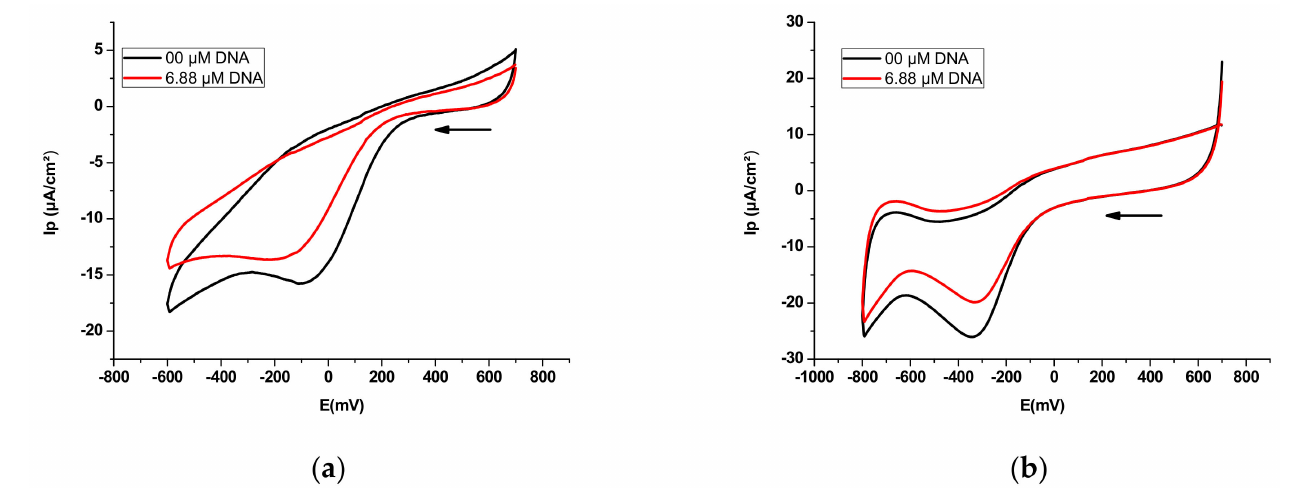
Figure 6. Cyclic voltammograms of polysaccharidic extract in 12 mL of 0.1 M phosphate-buffered solution (KH 2 PO 4 /K 2 HPO 4 , pH = 7.2) recorded at 0.1 V s − 1 potential sweep rate on a platinum disk electrode at 298 K in the absence and presence of 6.88 µ M DNA with supporting electrolyte 0.1 M Bu 4 NBF 4 : ( a ) extract E 2 (65 mg); ( b ) extract E 3 (60